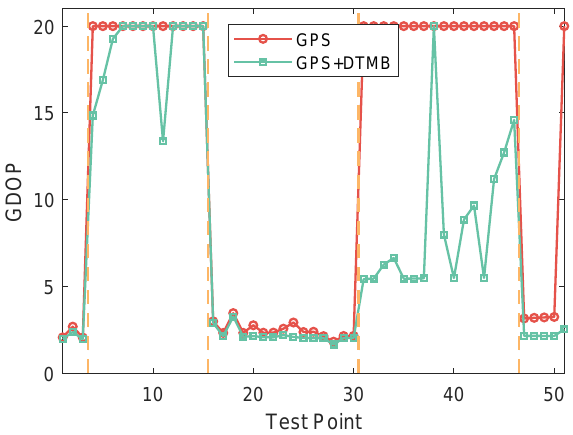
Figure 8. GDOP of GPS and GPS + DTMB at each test point at Site 1.